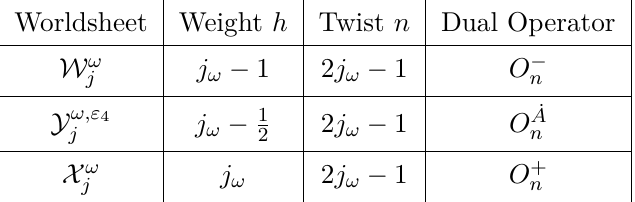
Table 1 . Dictionary between worldsheet vertex operators and chiral primaries of the holographically dual CFT. Here j = j + n 5 , and ω = 0 , 1 , . . . . ω , j = 1 , 3 , . . . , n 5 ω 2 2 2 √ ψ ω (0) = n e − i (1+ ω ) H 1 is the lowest-weight component of a spin J ω 5 corresponding x -basis operator is of the